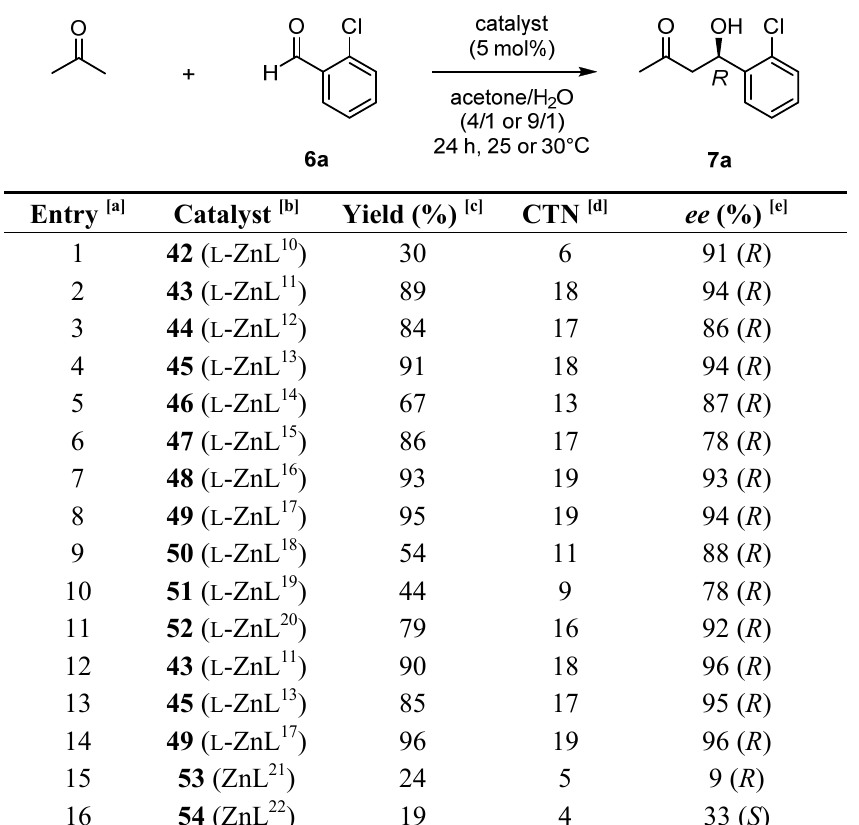
Table 3. Results for an asymmetric aldol reaction between acetone and 6a catalyzed by 42 – 54 ( L -ZnL 10 –ZnL 22 ) in acetone/H 2